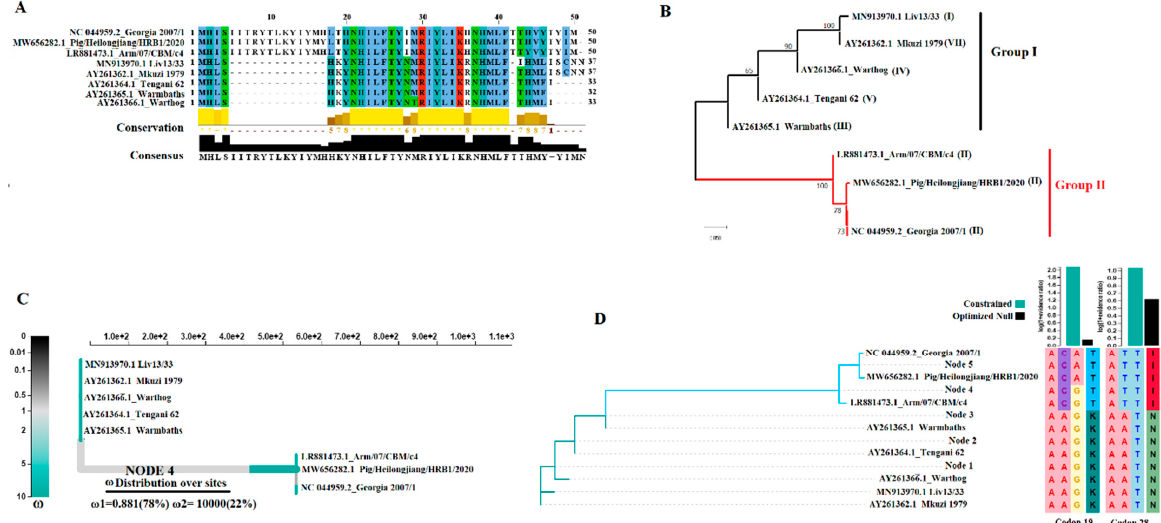
Figure 1. Evolutionary dynamics of E66L gene of ASFV. ( A ) Amino acid alignment showing the diversity of E66L protein among a group of representative ASFV isolates. Conservation plot scores reflect the nature of the change in specific sites. Increased scores reflect substitutions between residues with similar biological properties. Transmembrane domain (TMD) boundaries are limited by a red square. Analysis was conducted in the software Jalview version 2.11.1.7. ( B ) Phylogenetic analysis conducted by neighbor joining method using the full-length sequence of E66L gene supporting the existence of two phylogenetic groups. Numbers in the parenthesis indicate the genotype of different strains based on p72 classification. ( C ) aBRISEL analysis. Phylogenetic tree showing the w (dN/dS) rates at different branches associated with representative isolates included in this study. Evidence of positive selection was found on node 4, where two different classes of w (w1 and w2) were predicted. w values < or > than 1 are associated with negative or positive selection, respectively. Percentages in the parenthesis represent the proportion of codon sites associated with each class. ( D )